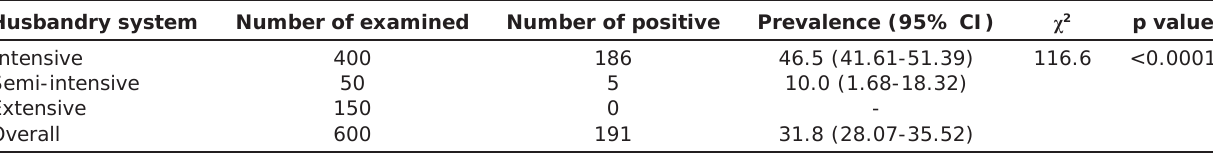
Table-3: Prevalence of coccidiosis according to husbandry systems in Maiduguri metropolis, Northeastern Nigeria. Husbandry system